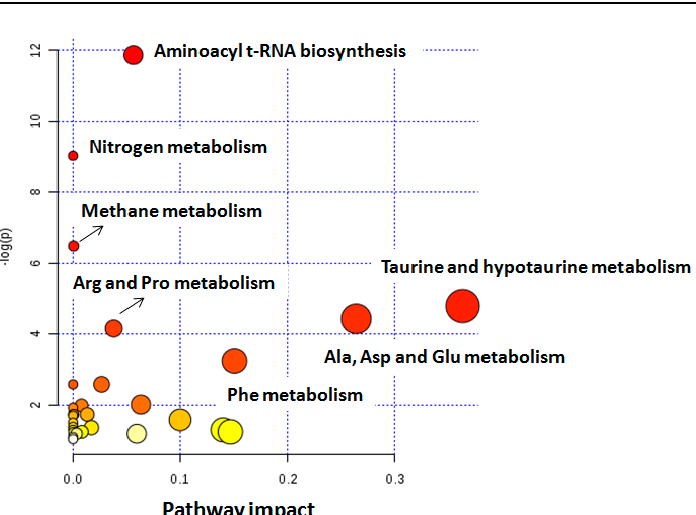
Figure 4. Analysis of altered metabolic pathways in BC. Note: the color and the size of each circle indicate its p -value and pathway impact value, respectively. Ala: alanine; Arg: arginine; Asp: aspartate; Glu: glutamine; Phe: phenylalanine; Pro: proline.